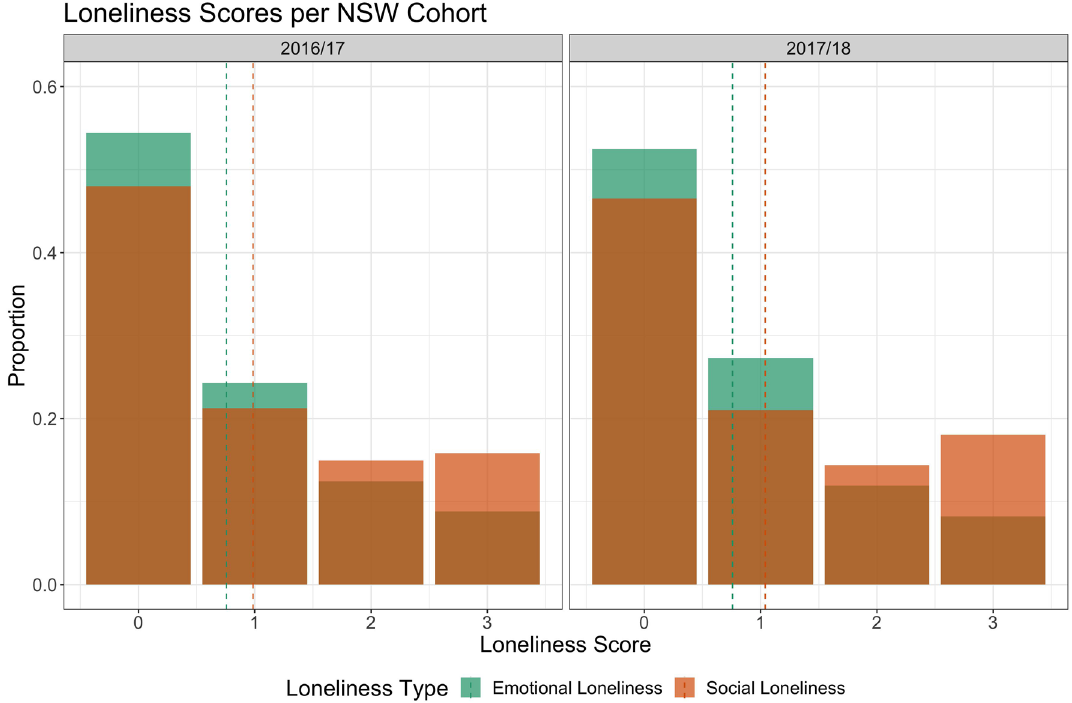
Figure 1. Social and emotional loneliness scores in the two NSW cohorts (2016/17 and 2017/18) (note: bars for social and emotional loneliness are overlapping). Scores for each loneliness type range between 0 (no loneliness) and 3 (severe loneliness). Dashed lines represent mean scores for each loneliness